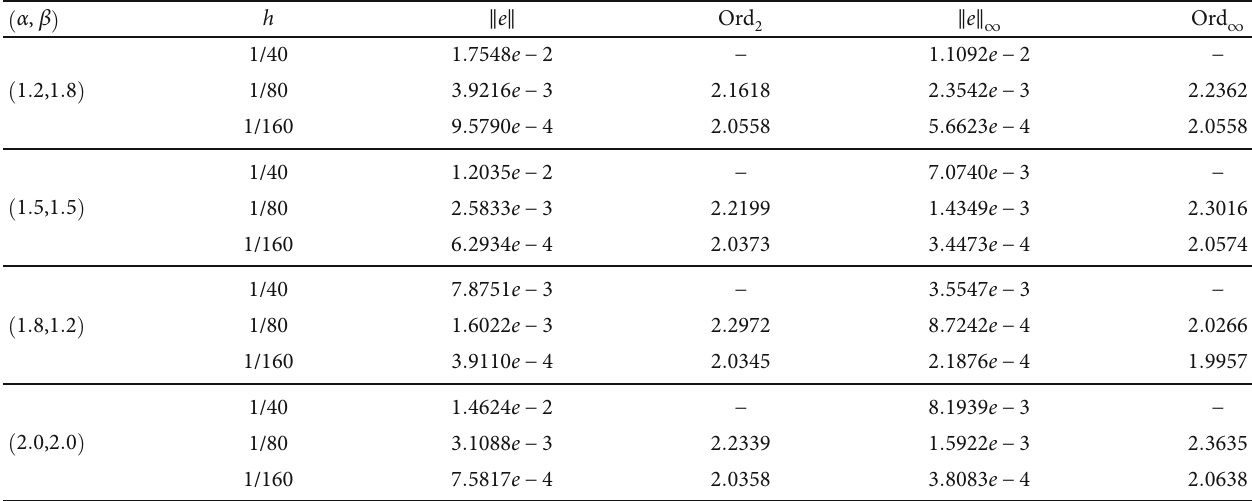
Table 7: l 2 -and l ∞ -errors and their convergence orders of (28) – (30) for 1 < α ⩽ 2 in the spatial direction with τ = 1/1000 for Example 4.